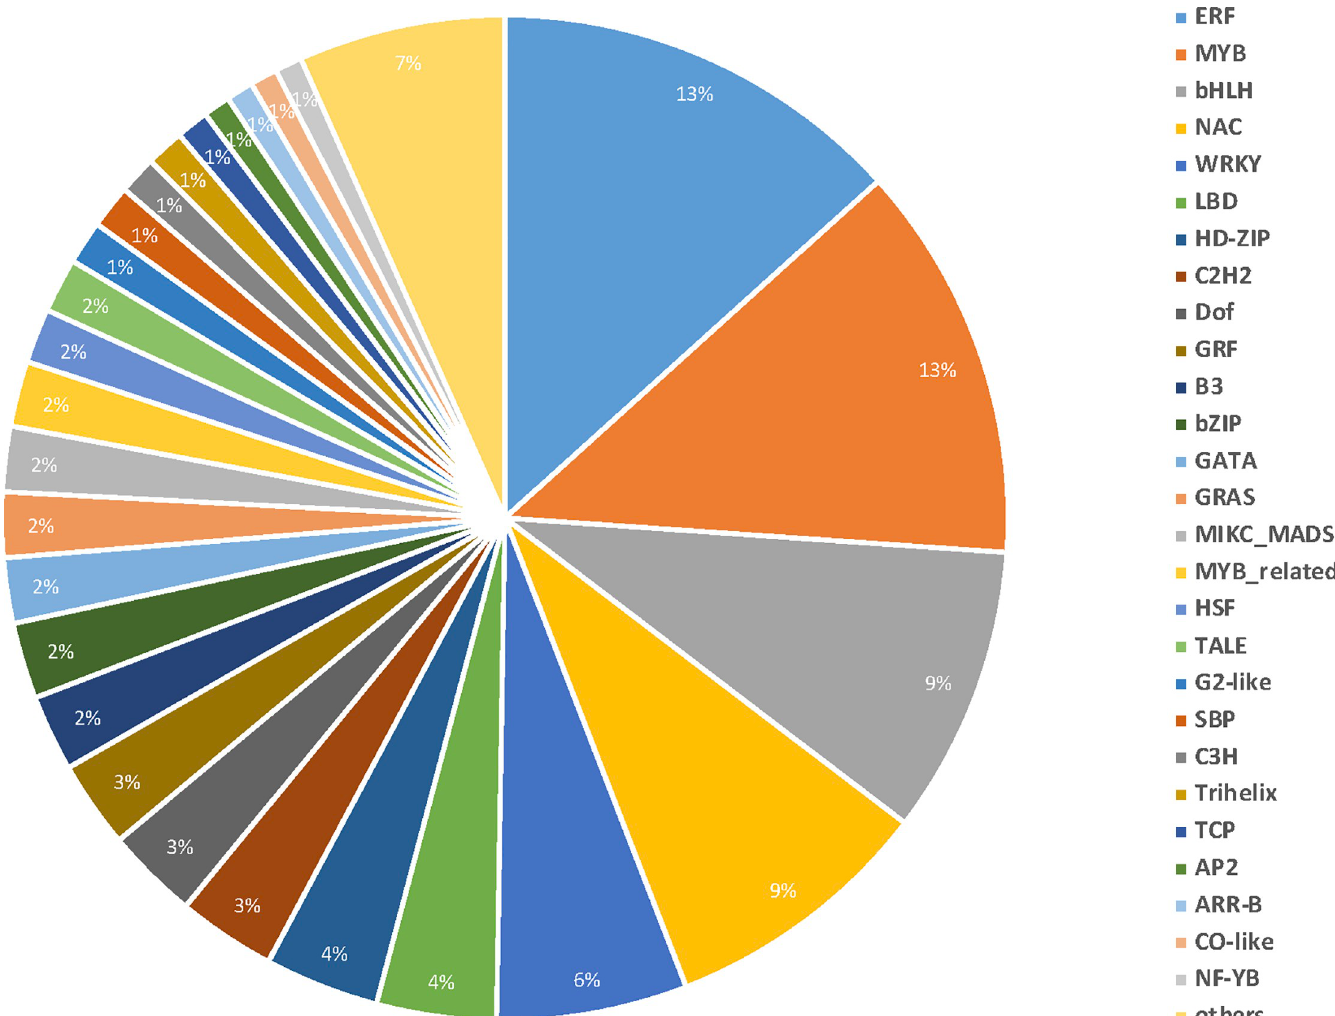
Fig 5. Distribution of G . hirsutum transcription factors families during RKN infection and development.